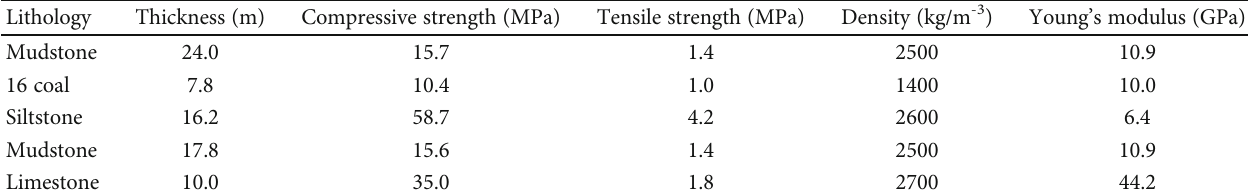
Table 1: Values of the parameters used to describe the properties of the strata.